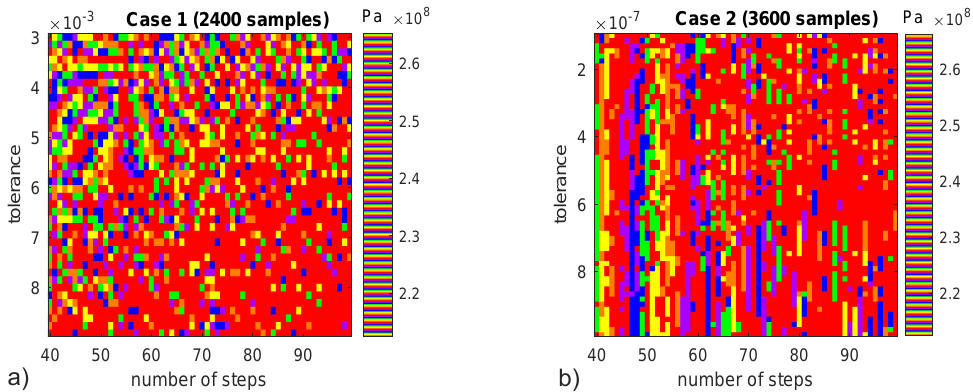
Figure 6. Moire Fringe interference patterns for two cases of number of steps and Newton method tolerance. For some regions of σ H results seem to follow a predictable pattern while in others there 2222 is only random noise. Colormap “prism” in Matalb is used to obtain the interference. ( a ) 2400 sample. ( b ) 3600